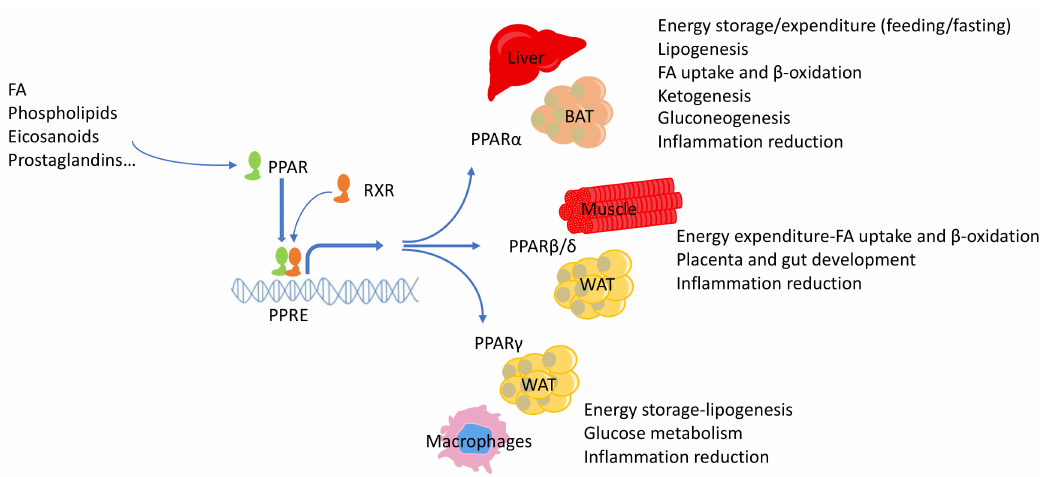
Figure 1. Activation and main functions of peroxisome proliferator-activated receptors (PPARs) in di ff erent tissues. PPARs share fatty acids (FA) as common ligands, peroxisome proliferator response elements (PPRE) as their DNA binding site, and retinoid X receptors (RXR) as their heterodimer partner. However, each PPAR shows distinct expression and function patterns. The dominant role of PPAR α is connected to metabolic adjustment in the liver and brown adipose tissue (BAT). PPAR β / δ is primarily associated with muscle and white adipose tissue (WAT) metabolism, as well as